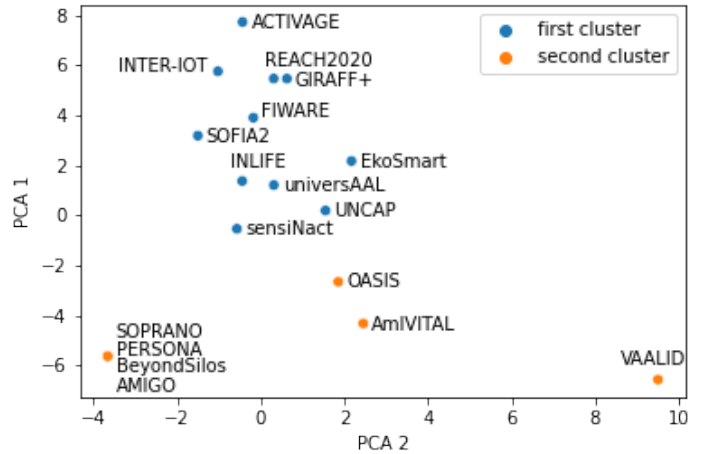
Figure 1. Result of k-means with two clusters and standardized input data.